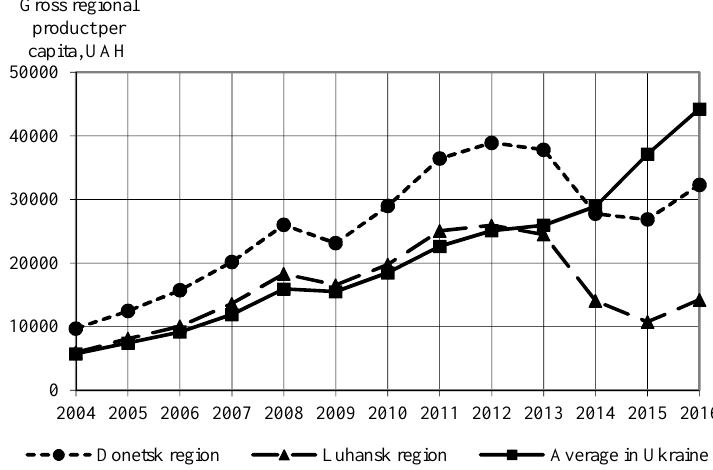
Figure 2. Dynamics of Gross regional product per capita of Luhansk and Donetsk regions compared to average value in